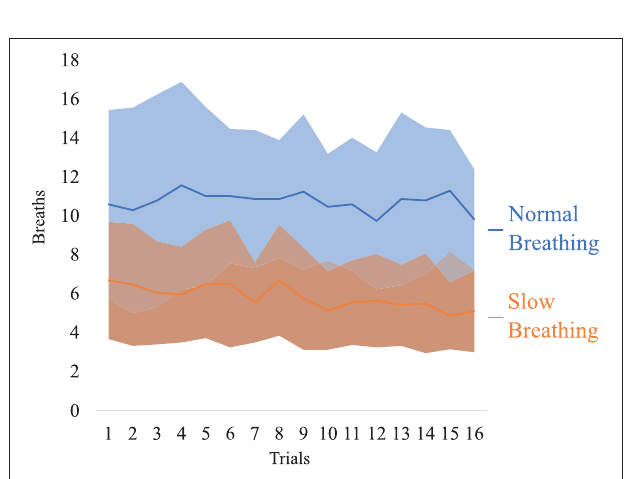
FIGURE 7 | Means (continuous lines) and standard deviations (shaded areas) of breaths per trial in conditions of Slow Breathing and Normal Breathing, along the 16 trials (1 trial per